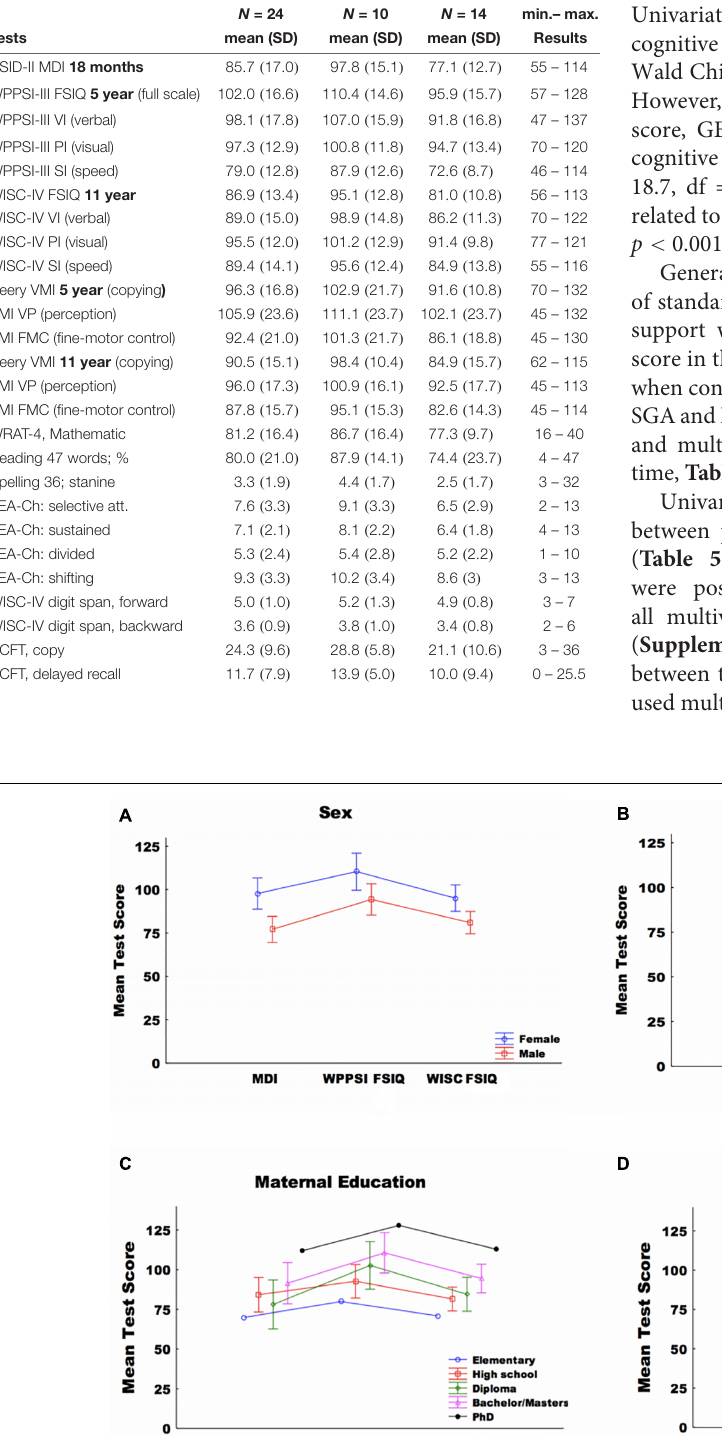
Frontiers in Physiology |